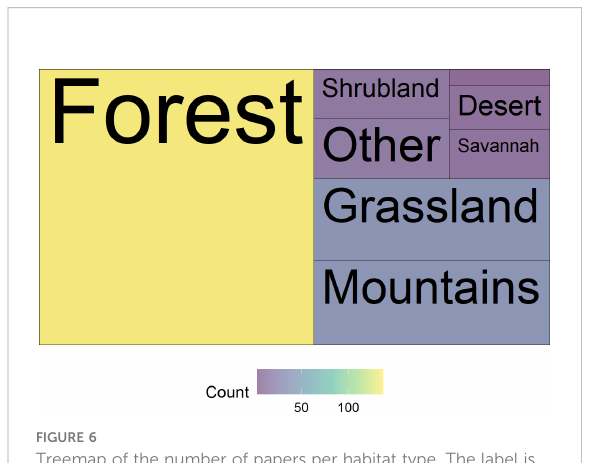
FIGURE 6 Treemap of the number of papers per habitat type. The label is omitted from the smallest category in the upper righthand corner, “ Wetland and riparian ” (n=3). “ Other ” includes categories such as “ home gardens, ” “ coastal, ” and “ disturbed ”